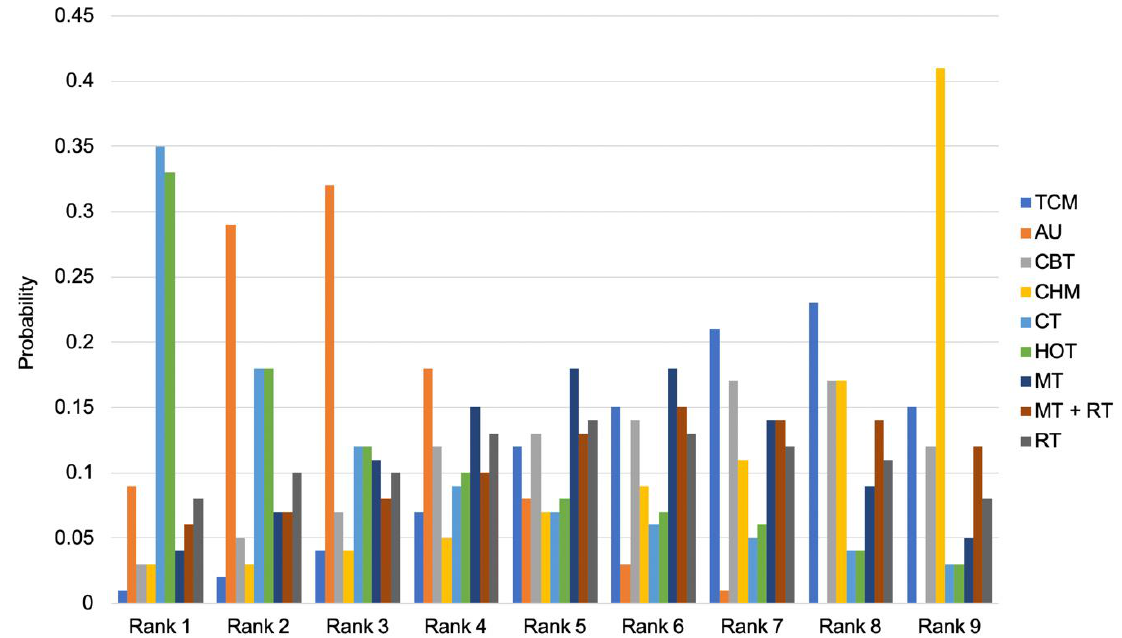
Figure 4. Rank probability of